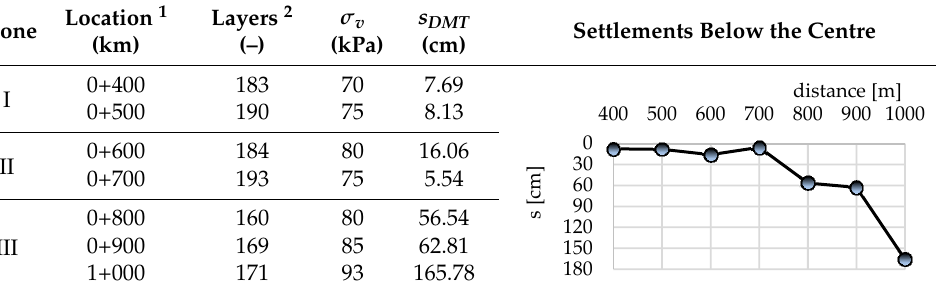
Table 2. Summary of results of settlements calculation, below the centre of embankment.